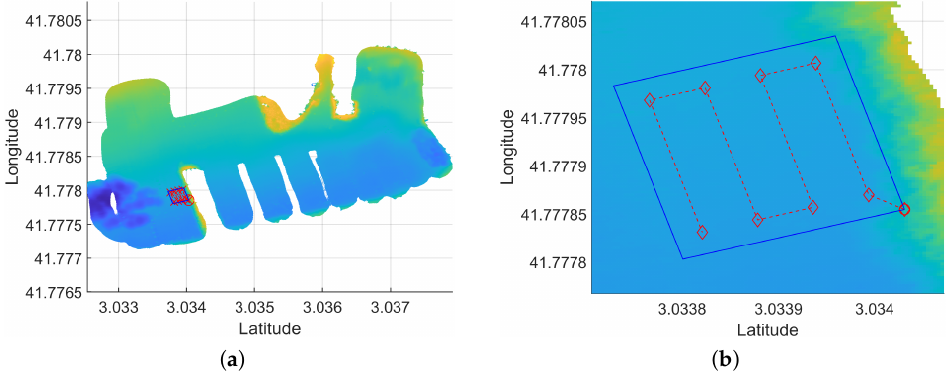
Figure 8. Bathymetry map with the coverage area (blue line) and predefined path (dotted red line) for the AUV in the harbor of Sant Feliu de Guíxols (Girona, Spain): ( a ) Map view, ( b ) Zoom view.